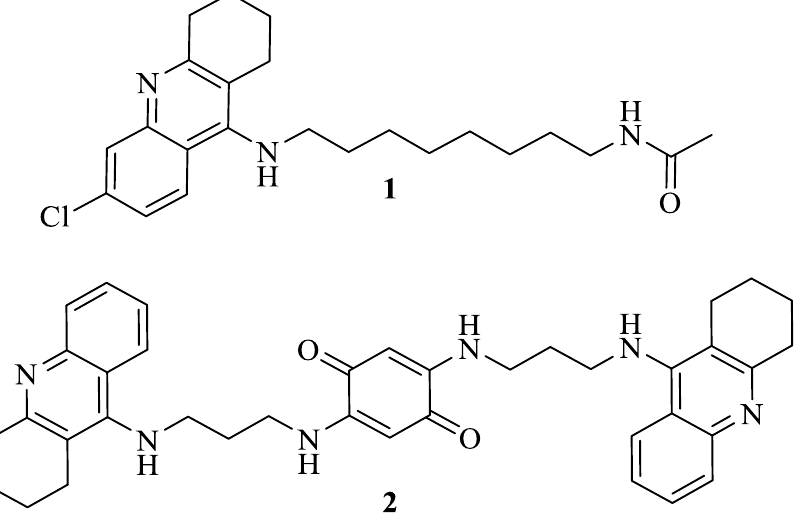
Figure 1. 1,2,3,4-Tetrahydroacridine derivatives indicated by the computational studies as promising antileishmanial agents.